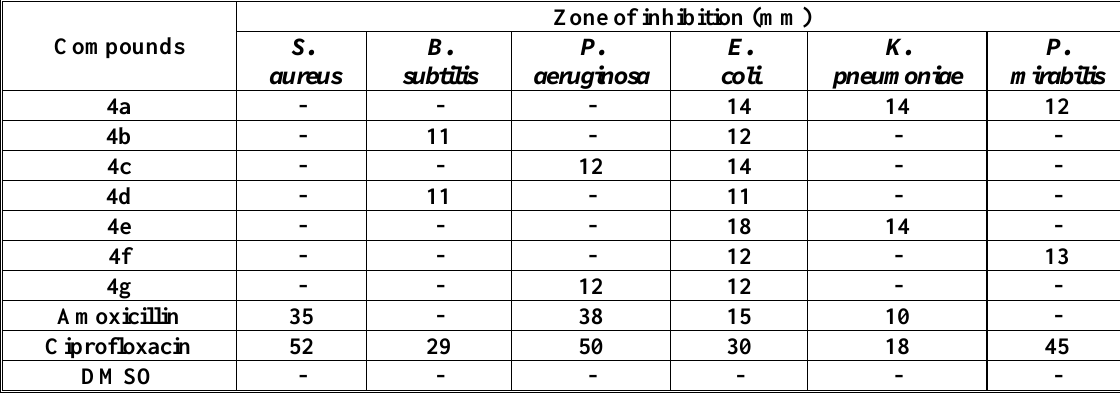
Table 2. In vitro antibacterial activity of the synthesized N-acyl hydrazones at 1mg/mL .